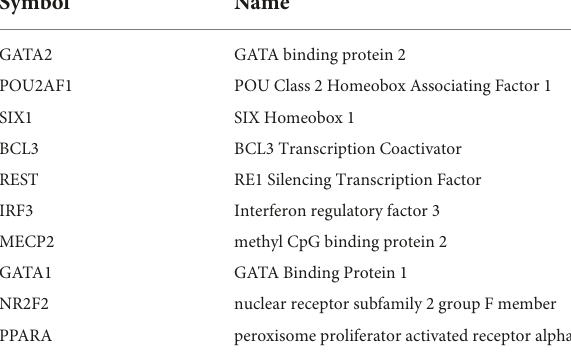
TABLE 1 Potential transcription factors that modulate differentially expressed protein coding genes with consumption of anthocyanin-rich black beans extract.